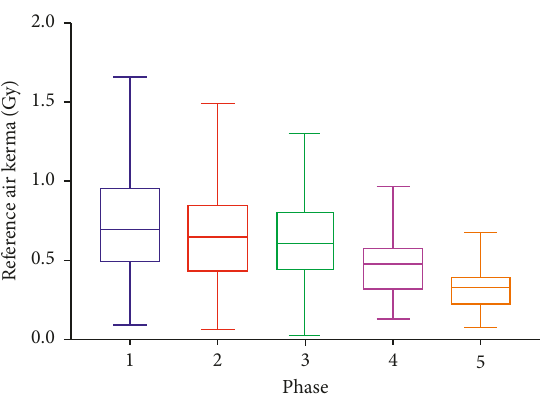
Figure 2: Median dose-area product values during the different phases of the study. The error bars represent first and third quartile values.